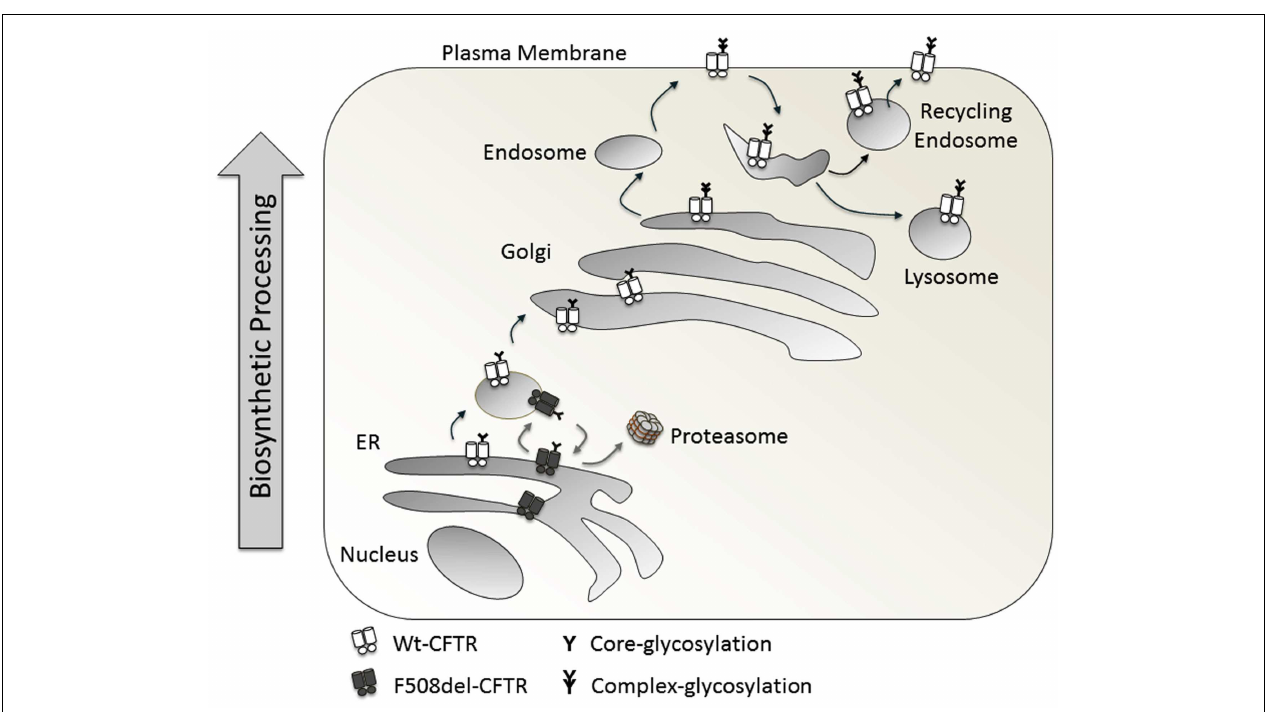
FIGURE 2 | Biosynthetic processing ofWt-CFTR and